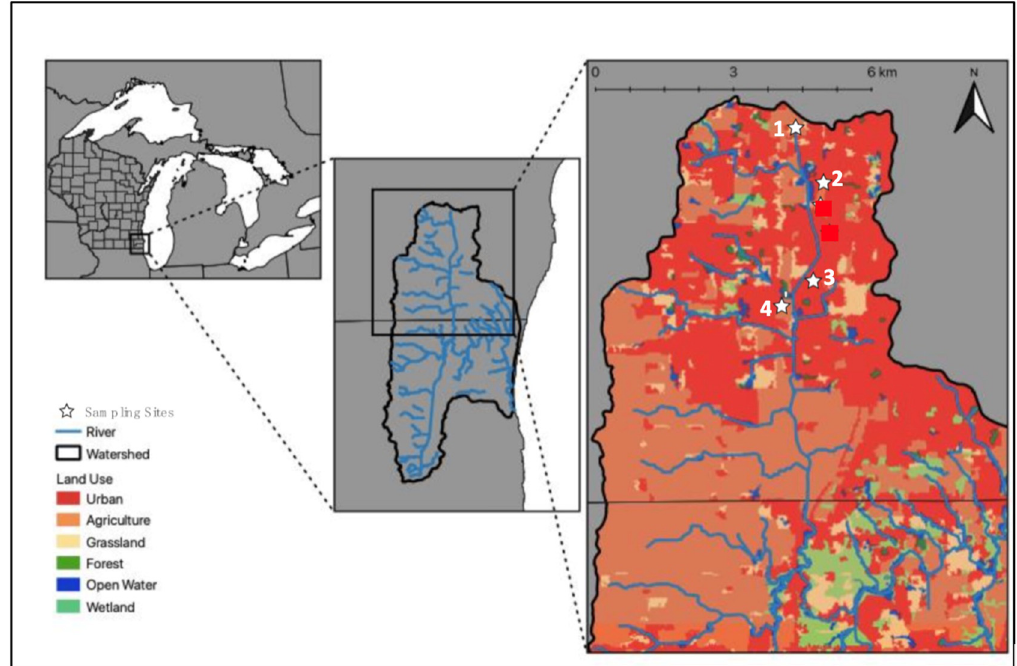
Figure 2. Map of the Pike River North Branch (42°43 ′ N and 87°57 ′ W) with the surrounding land use (adapted from Southeastern Wisconsin Regional Planning Commission, [25]). Wetland sampling sites are numbered as 1–4 from north to south. This figure is an adaptation from the figure published in [2]. Table 1. Wetland site characteristics, wetland sites 1–4 in the Pike River watershed (adapted from [2,25]). Land Use Percent in Pike River Watershed